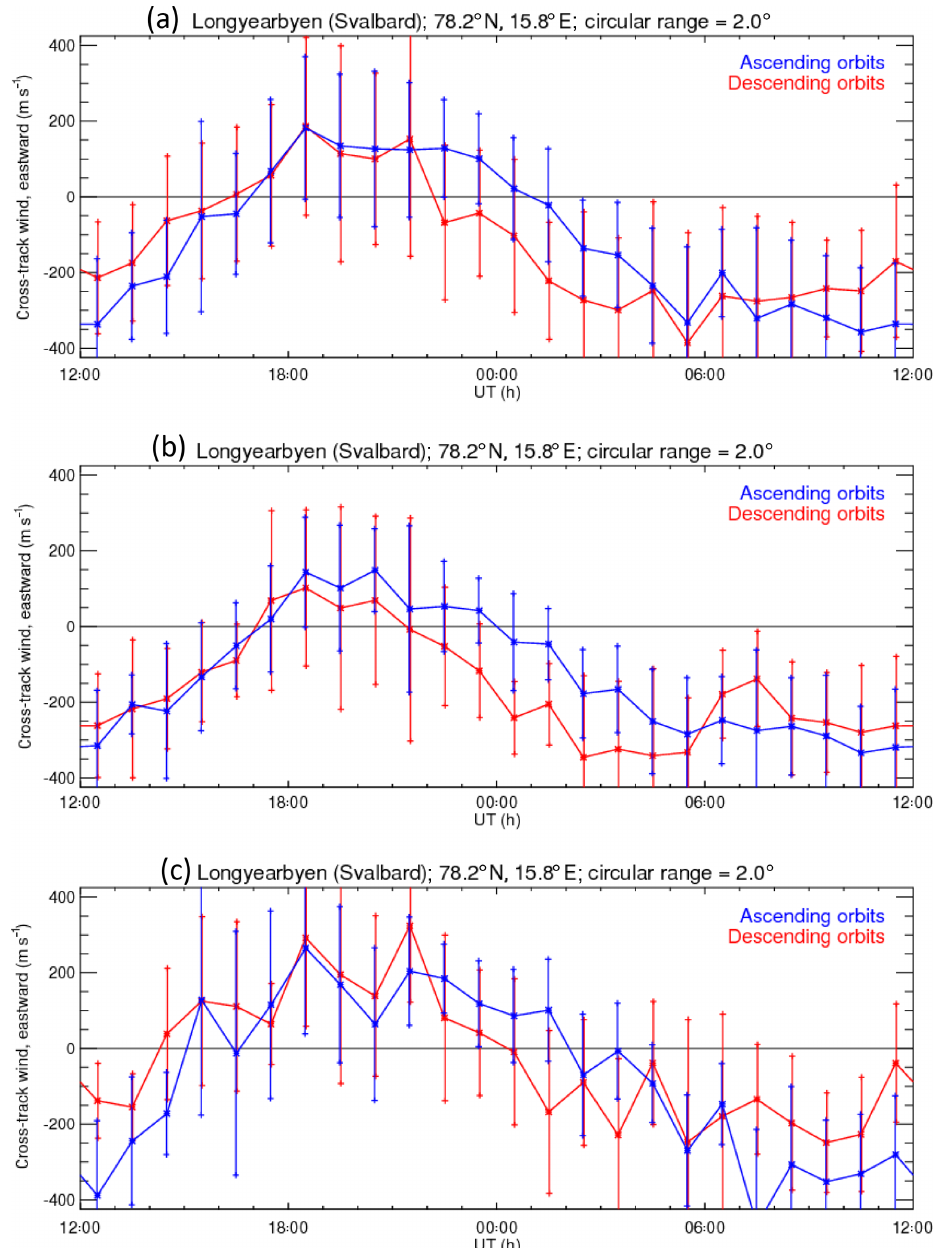
Figure 1. CHAMP observations over Longyearbyen during solar maximum 2001–2003. Panel (a) shows the average values for all data – ascending (blue) and descending (red), panel (b) shows summer (May–August) averages and panel (c) shows winter (end October–early March)